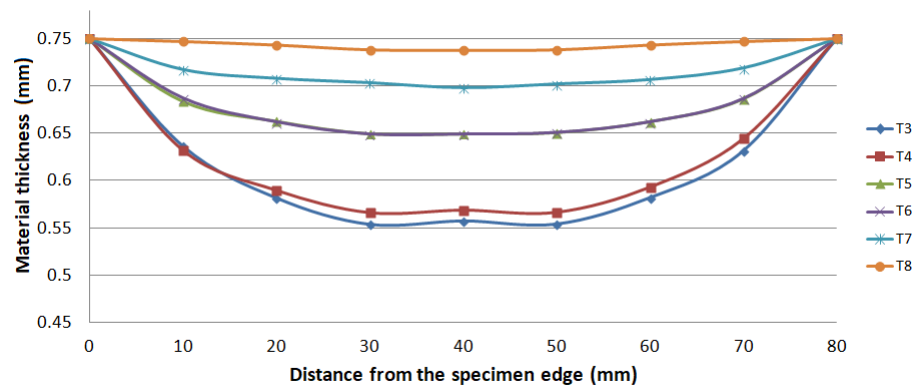
Figure 8. Material thickness values in 0° direction after bulge test.